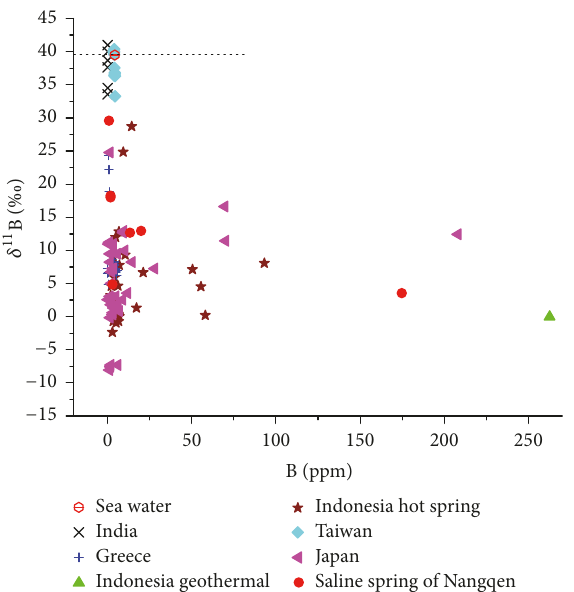
Figure 7: Comparison of springs worldwide. Data from India [12], Indonesia [13], Taiwan [14], Japan [15], and Greece